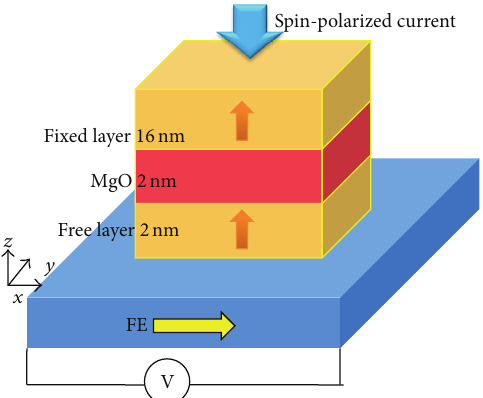
Figure1:SchematicstructureofCoFeB(2nm)/MgO(2nm)/CoFeB (16nm) magnetic tunnel junction spin